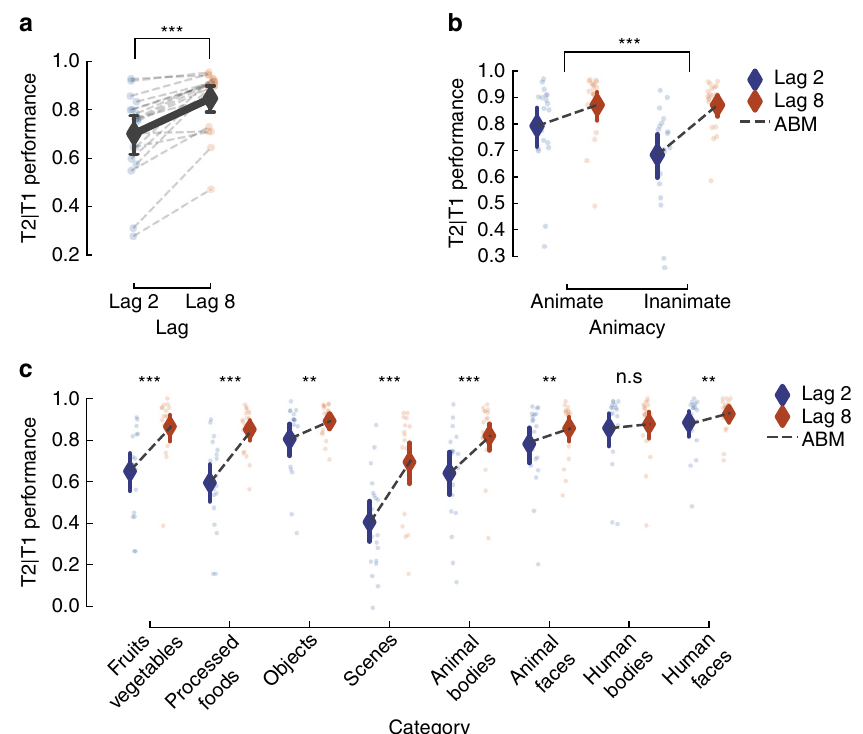
Fig. 2 Animate objects elicit weaker attentional blink. a The accuracy in detecting the second target conditional on having detected the fi rst target for lag 2 and lag 8. Individual dots represent the mean performance for each subject, bold dots represent the mean performance across subjects, and error bars indicate 95% con fi dence interval around the mean in all plots. b Performance plotted separately for animate and inanimate T2 targets. Attentional Blink Magnitude (ABM) is de fi ned as the difference in performance between lag 8 and lag 2. Asterisks indicate signi fi cant difference in ABM between animate and inanimate. c T2 performance for each category separately. Asterisks indicate an ABM signi fi cantly different from zero. Two-tailed-dependent t -test